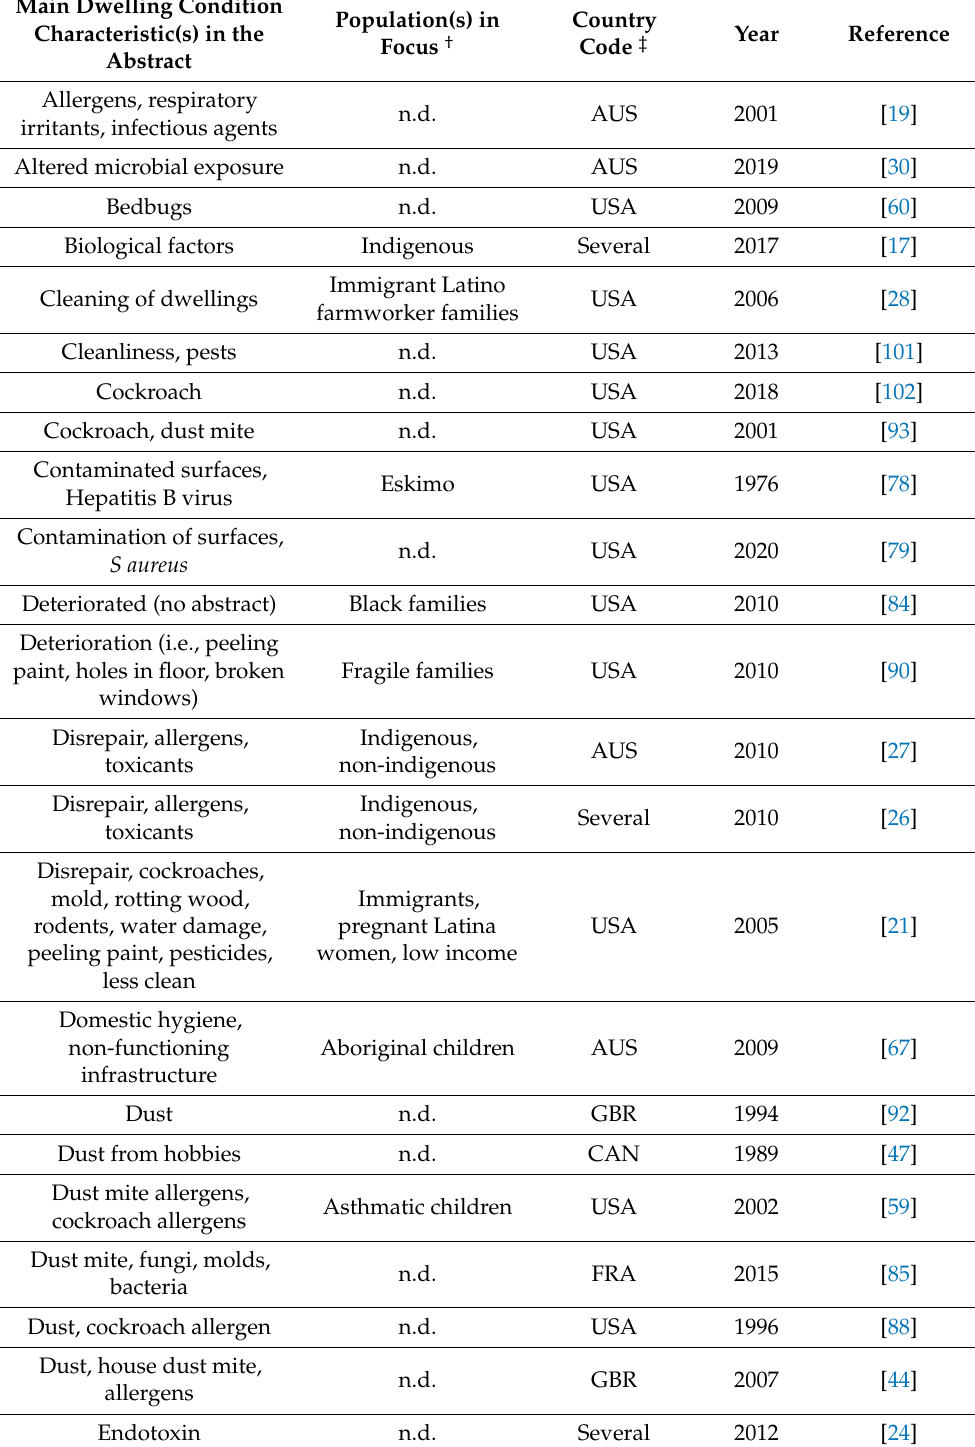
Table A1. Overview of content in the 100 records included in this scoping review. Country codes are given according to ISO Alpha 3 standard. Country code refers to the location of the dwellings under study. Year refers to the publication